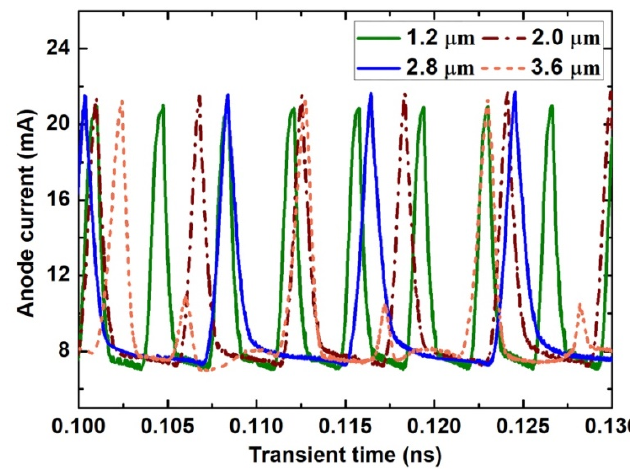
Figure 7. The current oscillation wave in the symmetric grooved-anode diode.